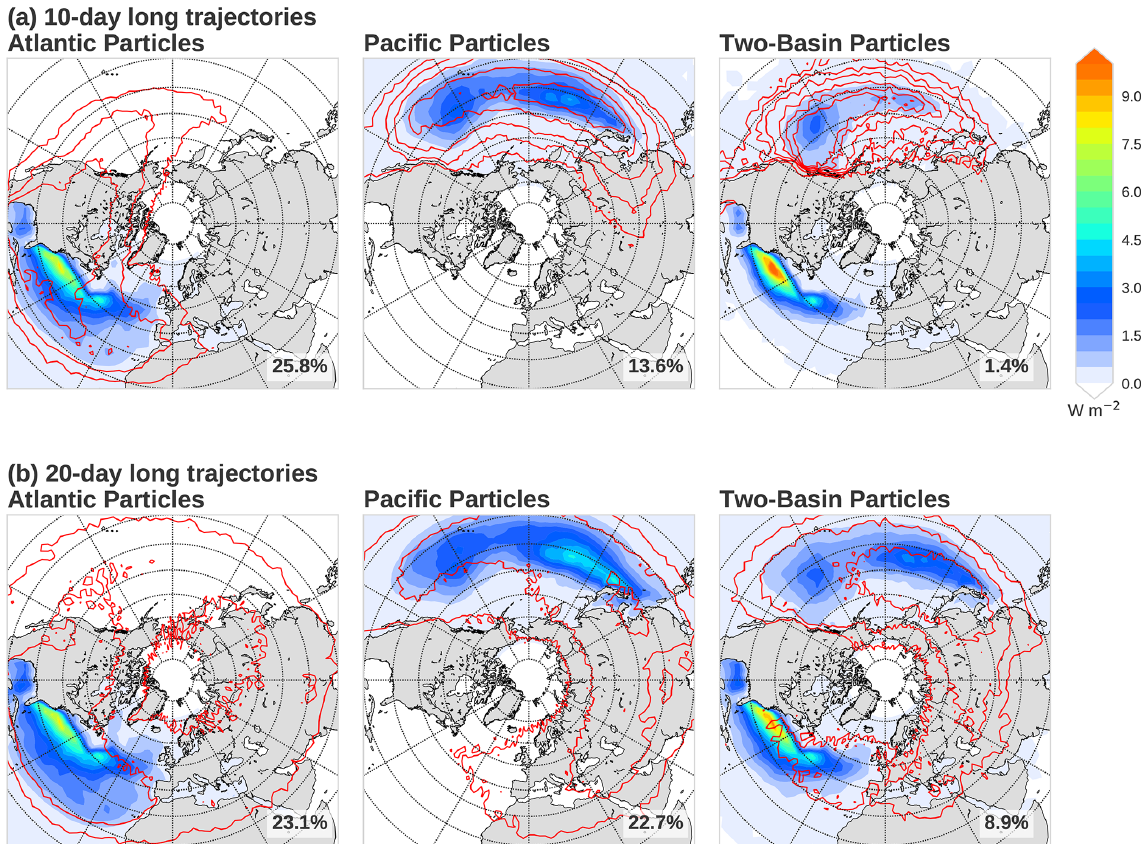
Figure 7. Total LHF along the moist particles found within each 2 ◦ × 2 ◦ grid cell over the whole (a) 10d and (b) 20d periods for backward particle tracking divided by the number particles of each moist-particle trajectory (colour shading) for the Atlantic particles (left column), Pacific particles (middle column), and two-basin particles (right column). The particle locations at (a) 10 and (b) 20d prior to their arrival in the blocks for each 2 ◦ × 2 ◦ grid cell are denoted by the red contours for 0.01%, 0.025%, 0.05%, 0,1%, 0.15%, and 0.2% in each panel. The percentage indicated in the bottom right corner of each panel denotes the percentage of the particles that belong to each moisture source category out of the total number of particles (i.e., dry and moist particles altogether). Parallels are plotted for every 10 ◦ , whereas meridians are plotted for every 30 ◦ on each